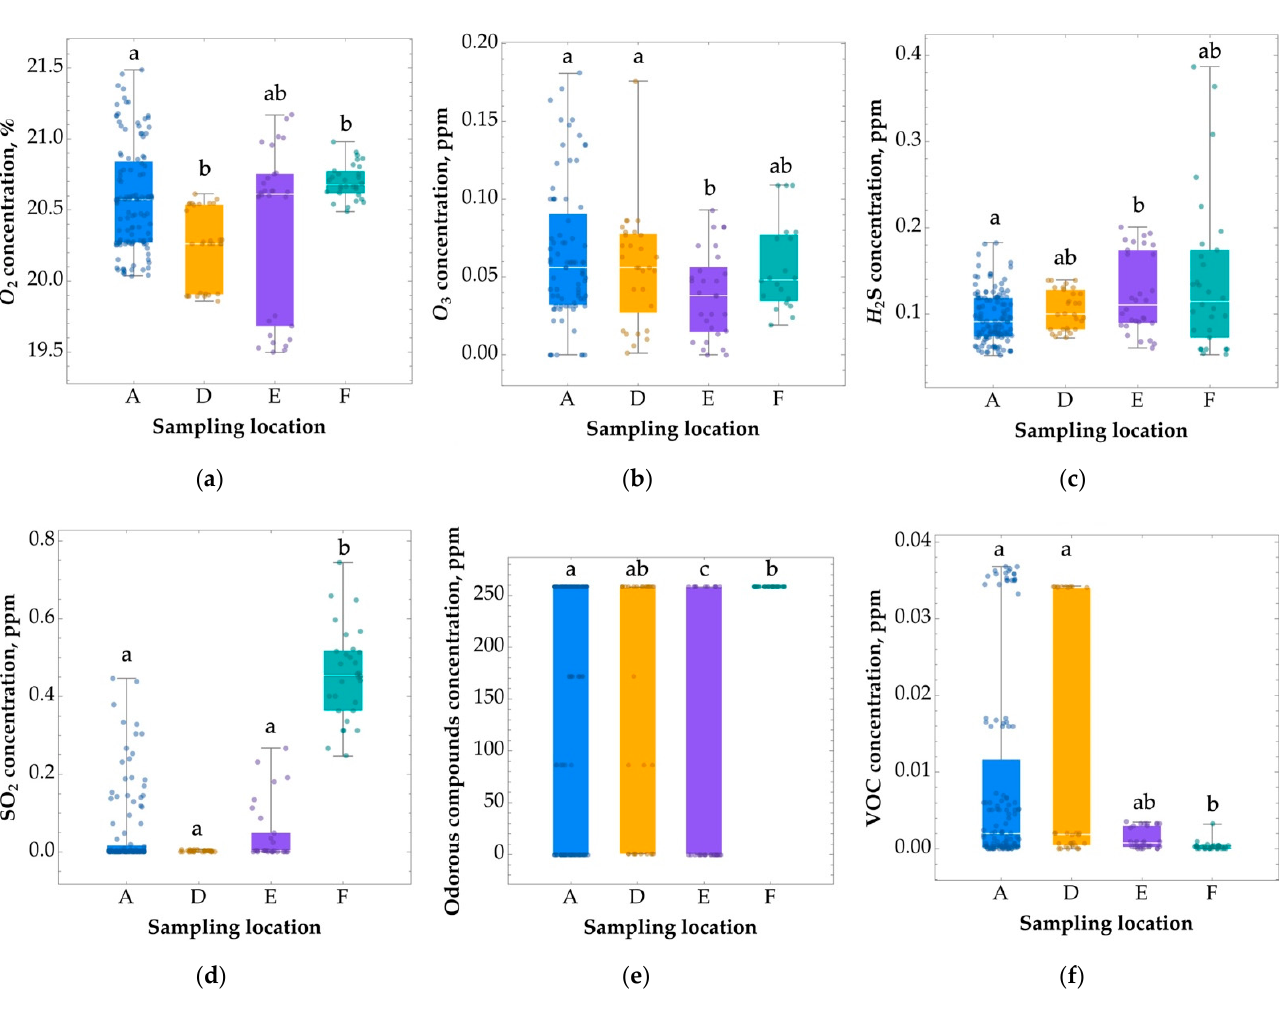
Figure 3. Box and whisker plots showing the averaged oxygen and chemical contaminant concen- trations at the selected locations. The whiskers represent the minimum and maximum values of all the data. Results with different letters (a–c) are significantly different from each other (Kruskal– Wallis test followed by Dunn’s posthoc tests at a significance level of 0.05). (A) “climbing wall”; (D) “basketball/volleyball court”; (E) “badminton court”; (F) “entrance to the building”. VOC— benzopyrene determined using an EcoWatch sensor with a metal oxide semiconductor detector (no other compounds were detected).